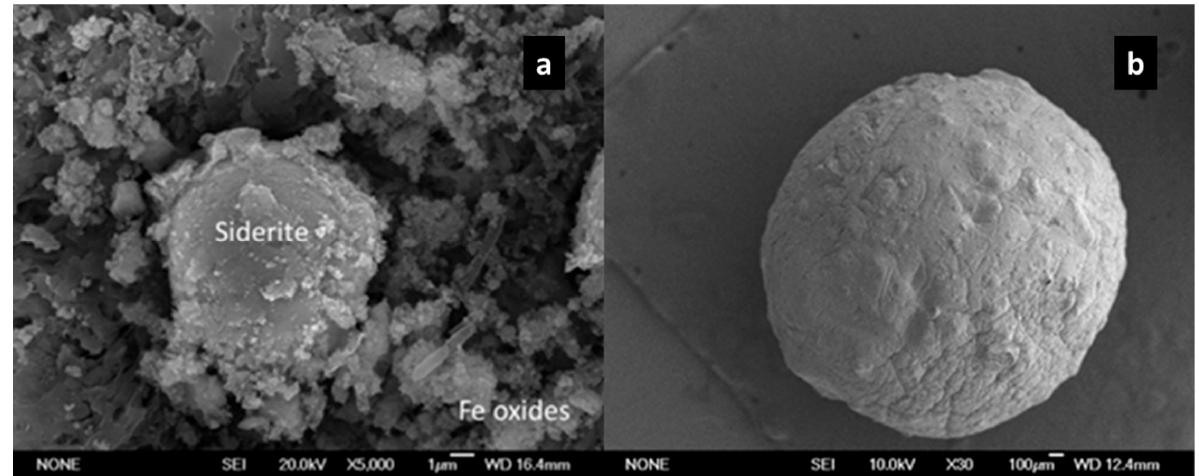
Figure 5. SEM images of ( a ) iron compounds produced by the microbial consortium and ( b ) alginate bead containing biogenic iron compounds.